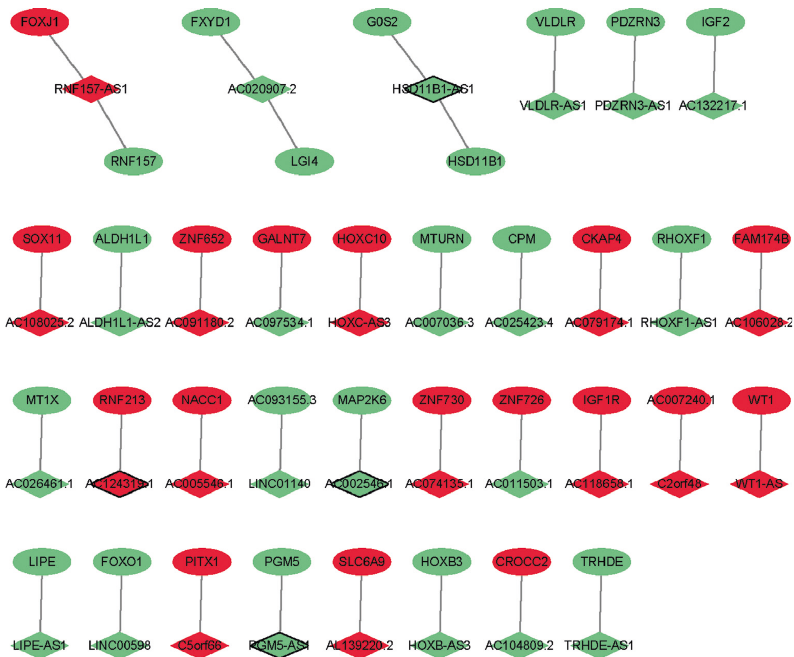
Figure 4: DElncRNA-nearby DEmRNA interaction network in luminal A breast cancer. Ellipse and rhombus represent DEmRNA and DElncRNA, respectively. Red and green colors represent upregulation and downregulation, respectively. The black border indicates the top 10 upregulated and downregulated